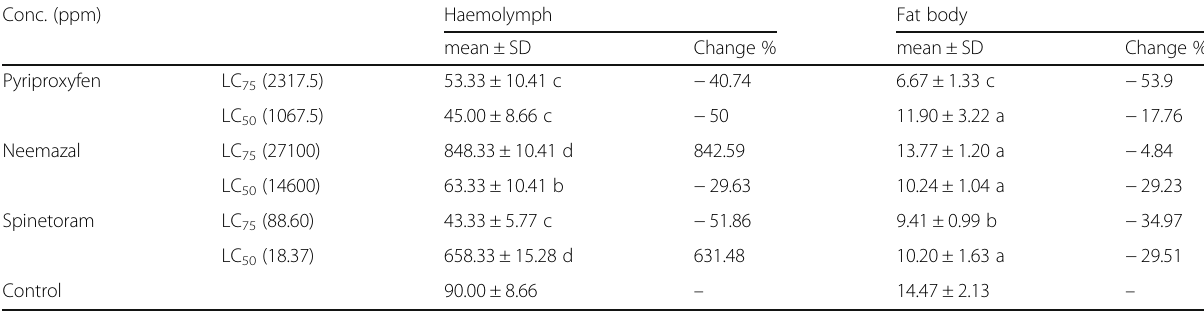
Table 3 GPT activity (U/L) in haemolymph and fat body of the early 5th instar larvae of Rh . ferrugineus after 24-h treatment with LC 50 and LC 75 of the tested insecticidal compounds Conc.